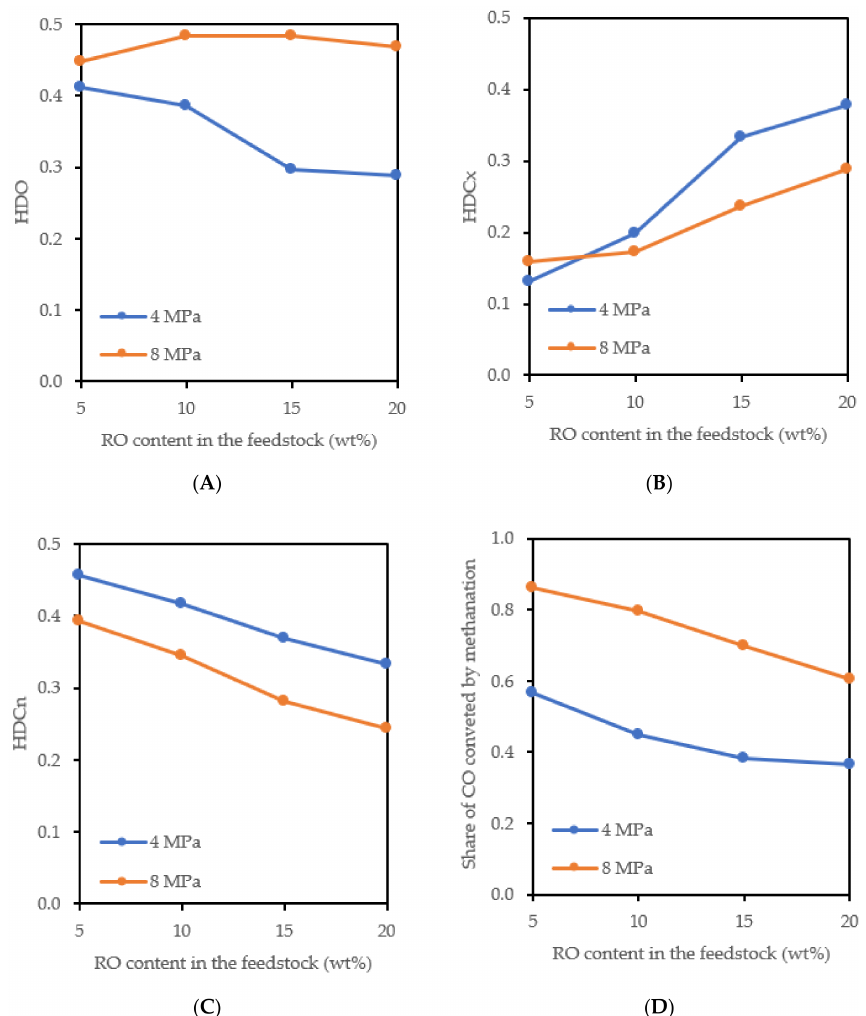
(Table 4), the hydrogen consumption for the HDS and HDN of the F0 feedstock at 8 MPa was only 5.5% and 0.8% of total hydrogen consumption, respectively.